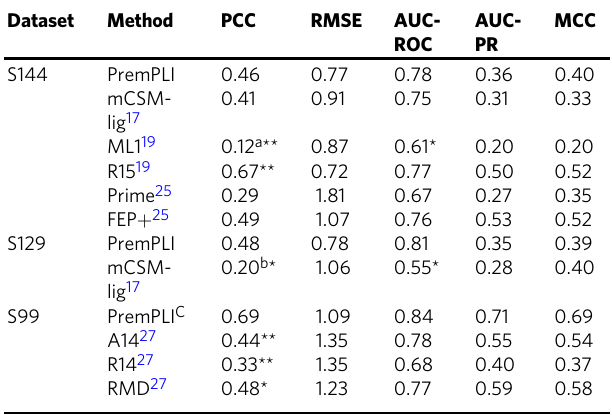
Table 1 Comparison of methods ’ performances on the datasets of S144, S129, and